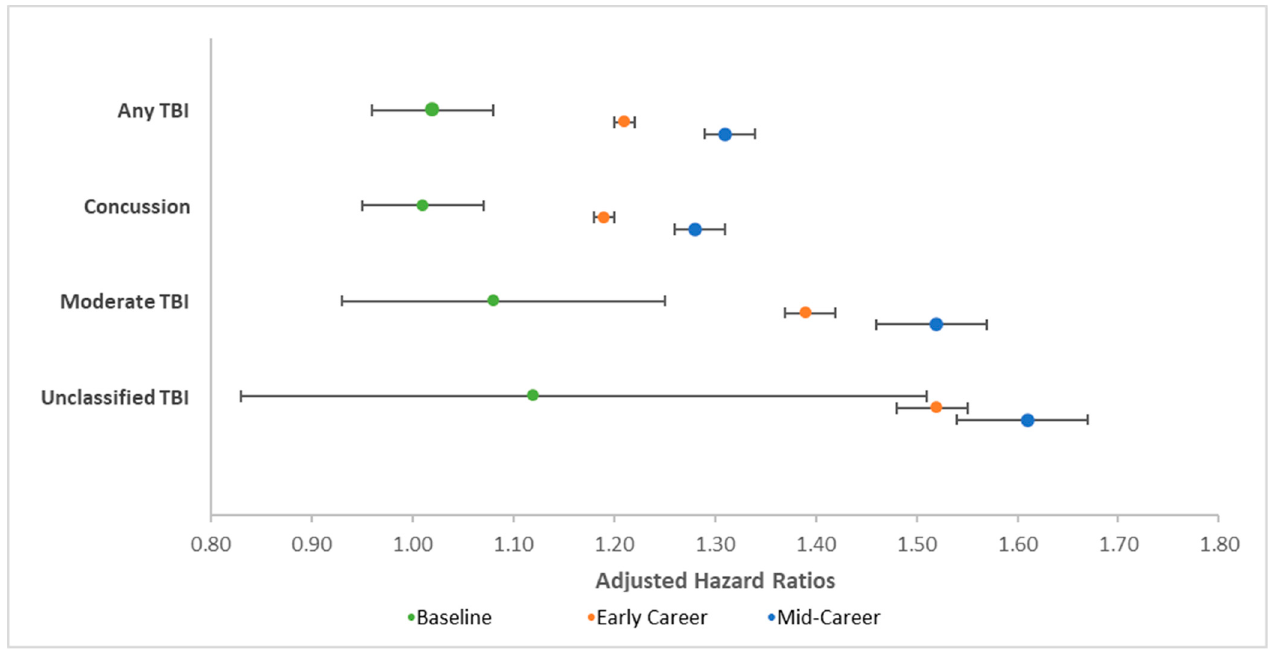
Figure 2. Graph of adjusted hazard ratios depicting decomposition of significant interaction between occupational risk of low-level blast (LLB) and time in risk for traumatic brain injuries (TBIs) of different severity. These adjusted hazard ratios represent the odds of being diagnosed with the conditions denoted as a function of occupational risk of LLB. Error bars represent 95% confidence intervals.